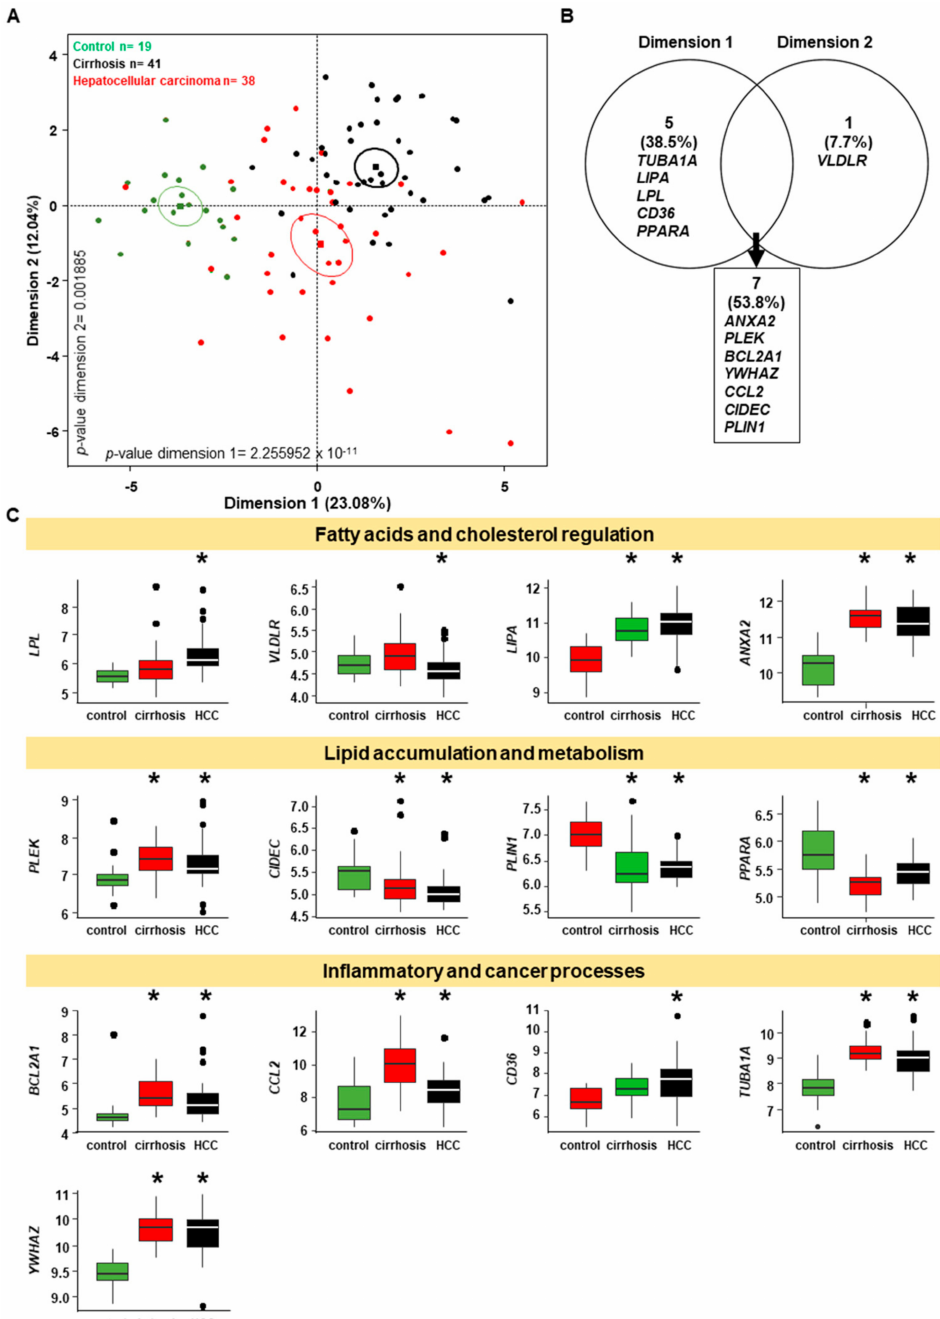
Figure 9. The genes involved in NASH progression are also involved in hepatocellular carcinoma. ( A ) Principal component analysis (PCA) based on the 30 genes implicated in NASH progression and run with the dataset of GSE14323 implicating control ( n = 19), cirrhosis ( n = 41) and HCC ( n = 38) liver biopsies separated significantly on the first dimension and second dimension. ( B ) Venn diagram based on the genes (i.e. variables) implicated of the separation of the three groups of patients from the PCA ( A ) leading to a total of 13 genes. ( C ) Boxplots of the expression of the 13 genes in the in each group control, cirrhosis and HCC compared by ANOVA one-analysis. * p <